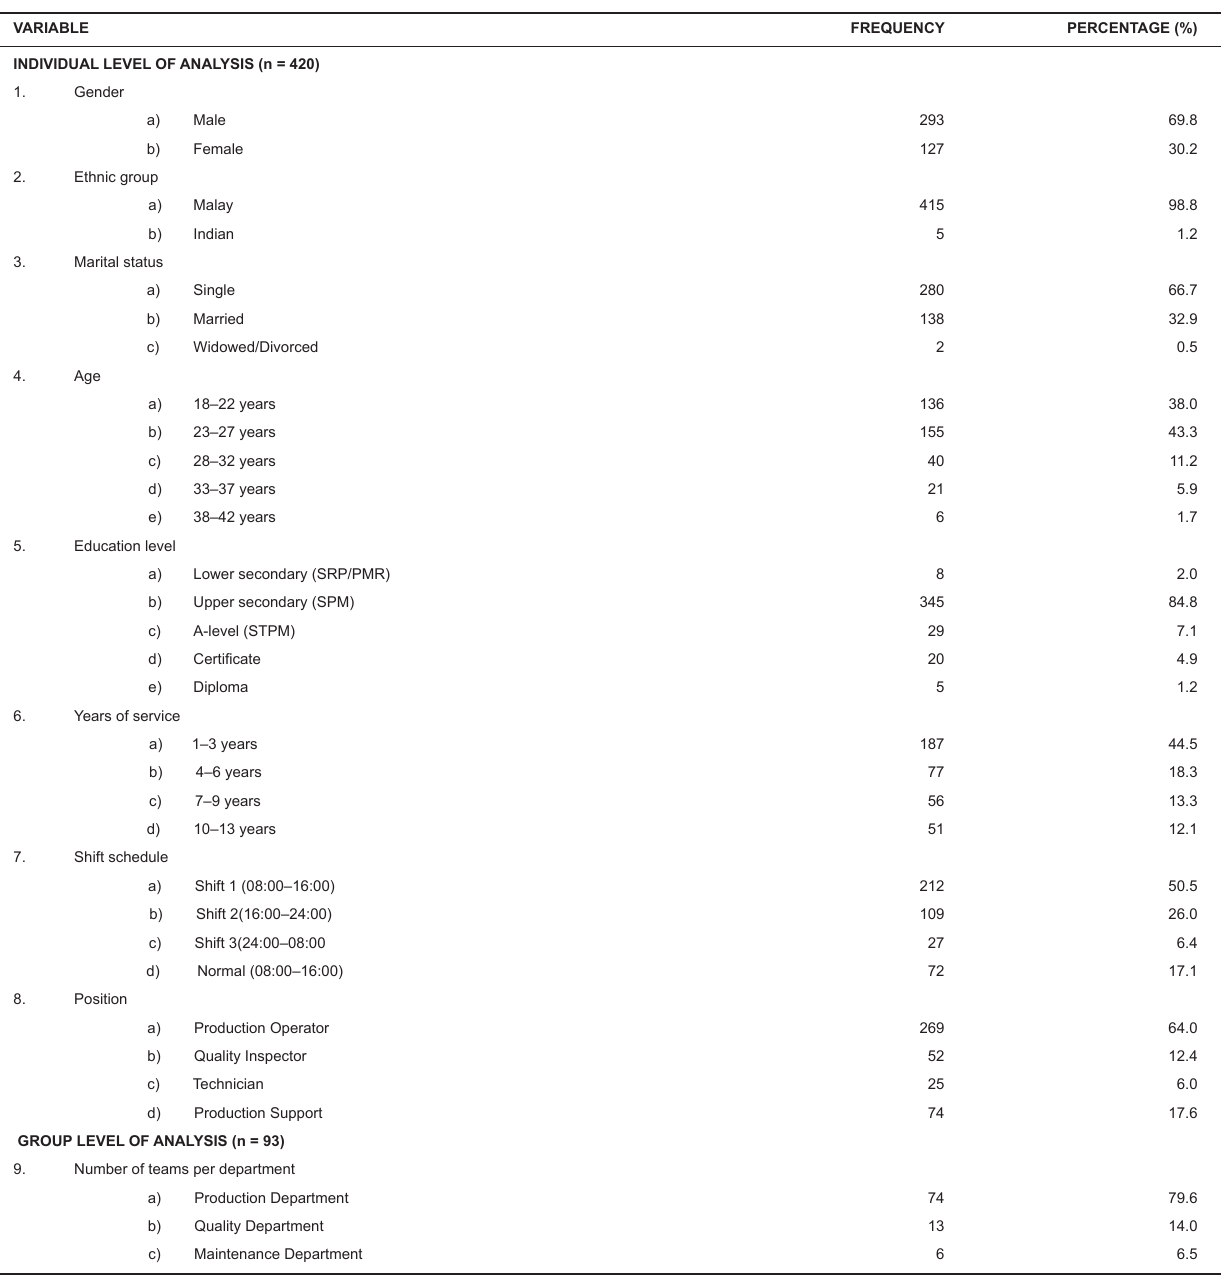
TABLE 2 Demographic profile of respondents at individual (n = 420) and group level of analysis (n =